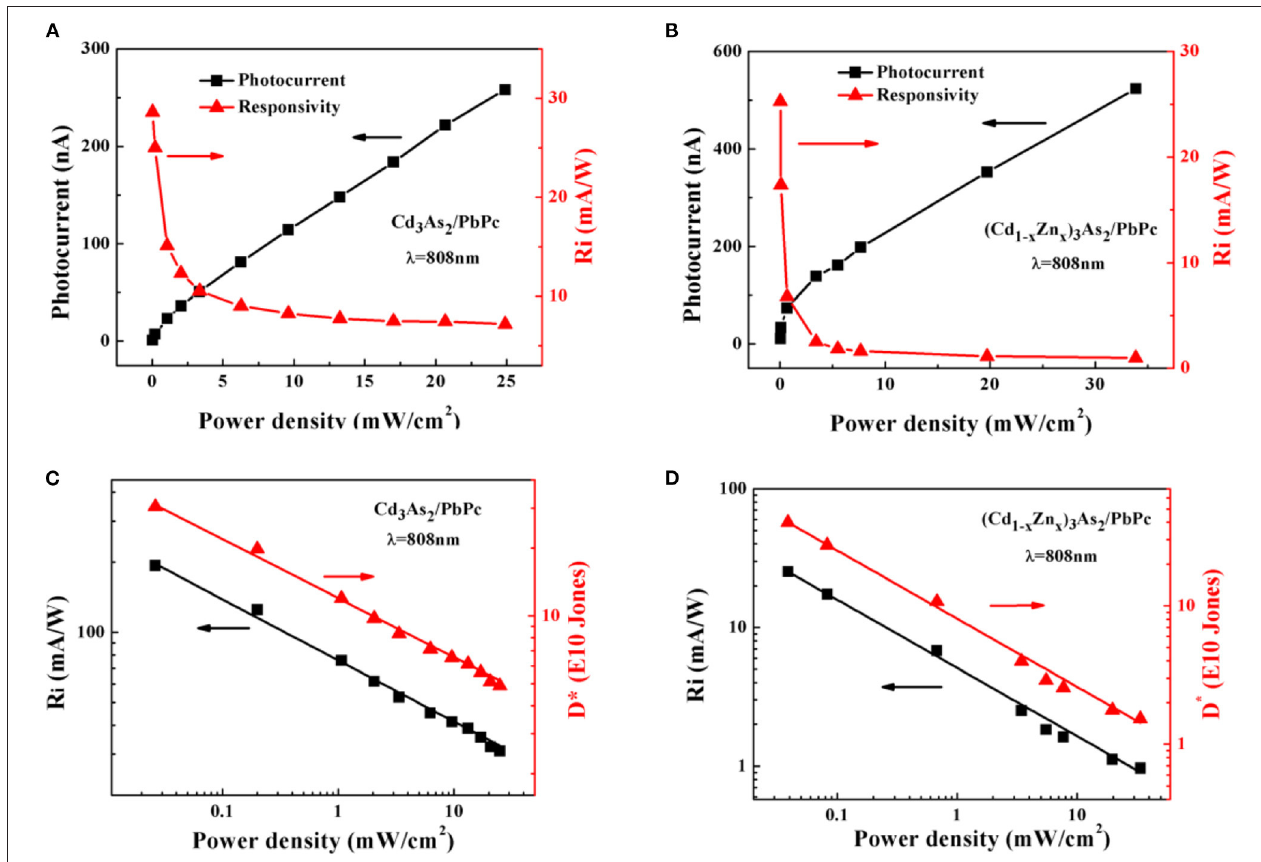
FIGURE 4 | (A,B) Variation of the photocurrent (left axis) and R i (right axis) of DSM/PbPc photodetector with the different intensities of illumination at the laser wavelength of 808nm. (C,D) R i (left axis) and D* (right axis) curves of DSM/PbPc photodetector under light illumination with different power. The measurements were performed in ambient conditions with V 1V and the laser wavelength of = −